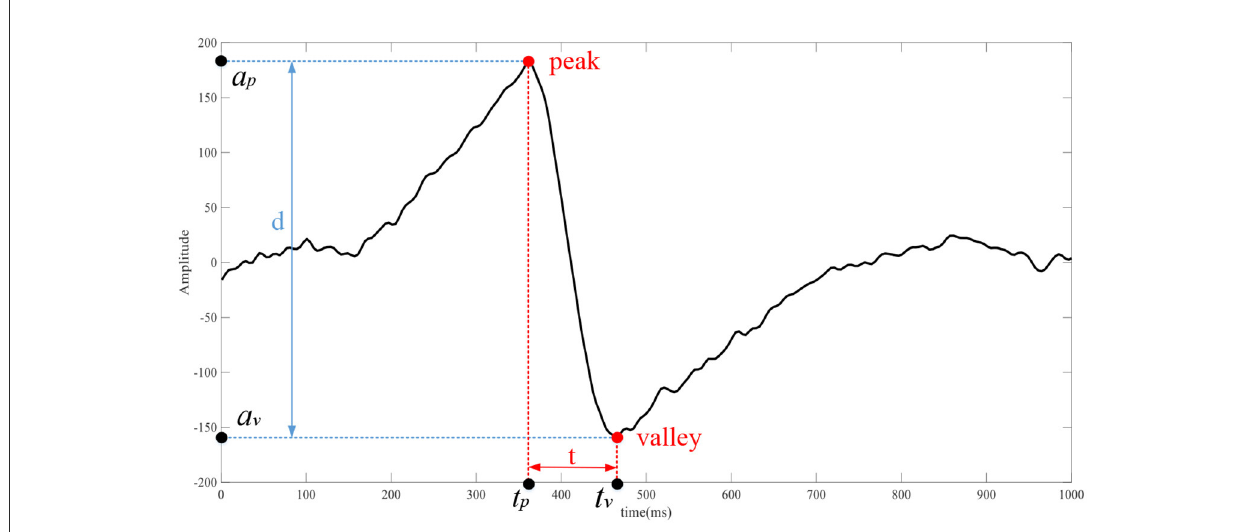
FIGURE5 The waveform of the corresponding channel of eye movement, d is the distance between the peak and the valley, and t is the time difference between the peak and the valley.